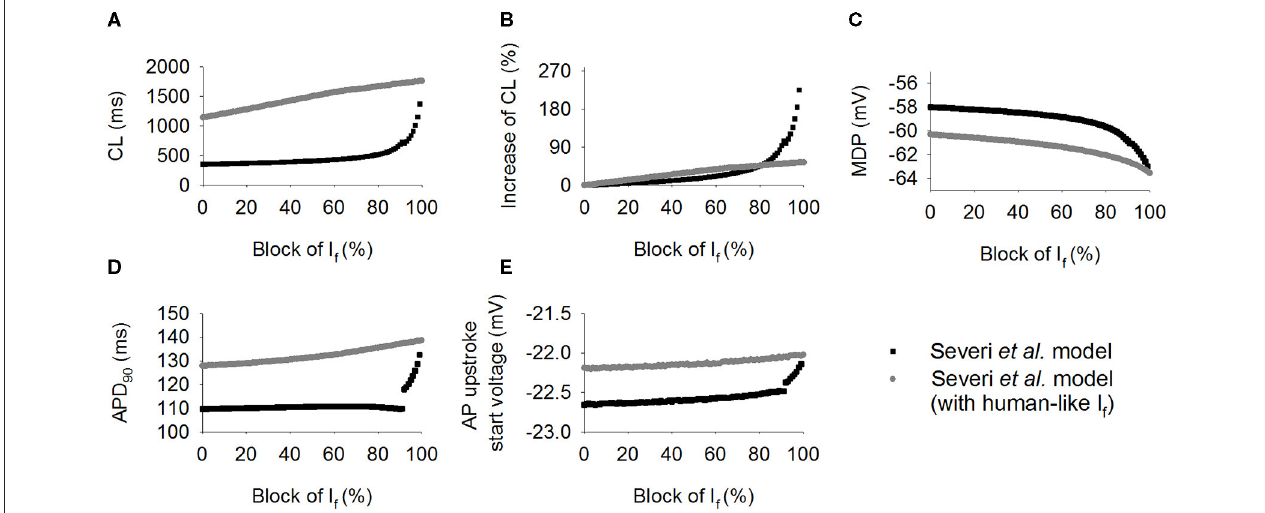
FIGURE 5 | Simulated effect of I f block on the CL increase. (A,B) Pacing cycle length and the relative percentage changes of CL when I f blocked from 0 to 100% with 1% increment in the human-like (open circle) and rabbit-like (closed circle) SAN cell models; (C,D) the maximum diastolic potential (MDP) and action potential duration at 90% of repolarization (APD 90 ); (E) change of the beginning of action potential upstroke voltage, which was calculated as the diastolic depolarization rate reached about 50% of its maximum value. I f block produced greater effect in the human-like (gray circle) and rabbit-like (black square) SAN cell